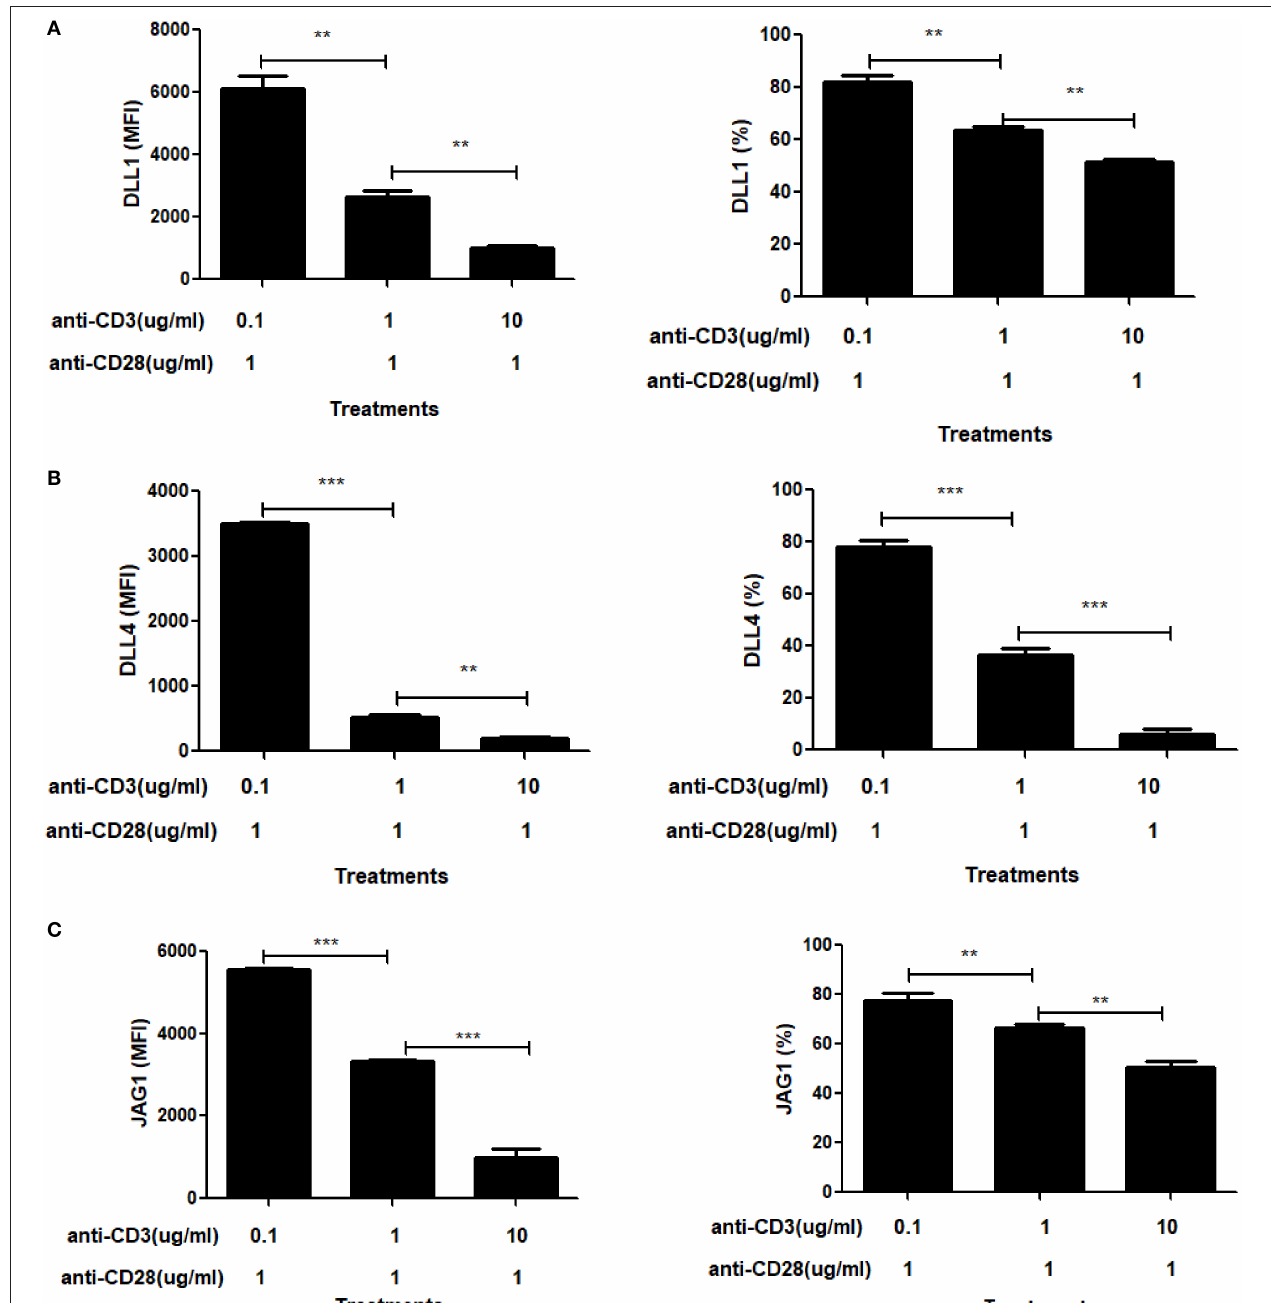
FIGURE 6 | Signal through CD3 shows a dose dependent suppressive effect on Notch ligand expression. CD4T cells from C57BL/6 mice were stimulated with the indicated concentrations of anti-CD3 + and 1 mg/mL of anti-CD28 for 6h. Cells were harvested and analyzed by flow cytometry by gating on live cell population as determined by absence of Zombie staining. MFI values and percentage of ligand positive cells were plotted for (A) DLL1, (B) DLL4, and (C) JAG1. Histograms to the right of (A–C) show expression of DLL1, DLL4, and JAG1 with indicated treatments. Data represents three independent experiments MFI value. Data represent mean ± SEM. ** p < 0.005 and *** p <